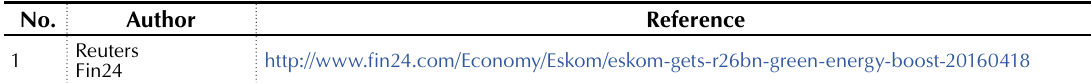
Table 4B. Technological macro-environment